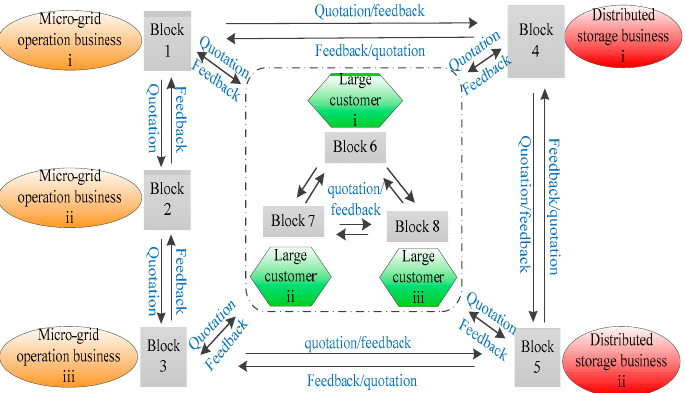
Figure 6. Basic structure of microgrid group.